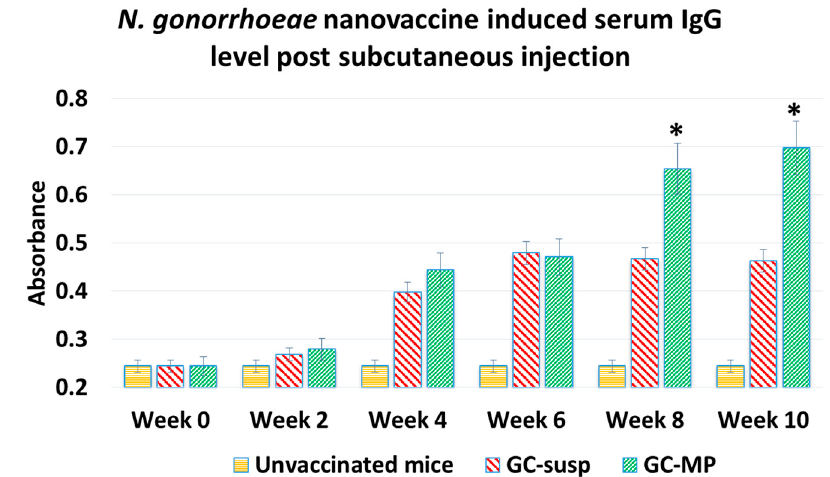
Figure 5. N. gonorrhoeae -specific antibody measurement in serum using ELISA. The mice received one prime dose subcutaneously at week 0 followed by 2 booster doses at week 1 and 2. The vaccinated mice groups receiving either GC suspension or GC microparticles vaccines showed significantly higher serum IgG levels from week 4 till week 10, when compared to the unvaccinated mice group ( p < 0.05). At week 8 and 10, the group receiving microparticulate vaccine showed significantly higher response compared to the subcutaneous vaccine group (* p < 0.05). GC-susp: N. gonorrhoeae antigen in suspension; GC-MP: N. gonorrhoeae antigen-loaded in microparticles.